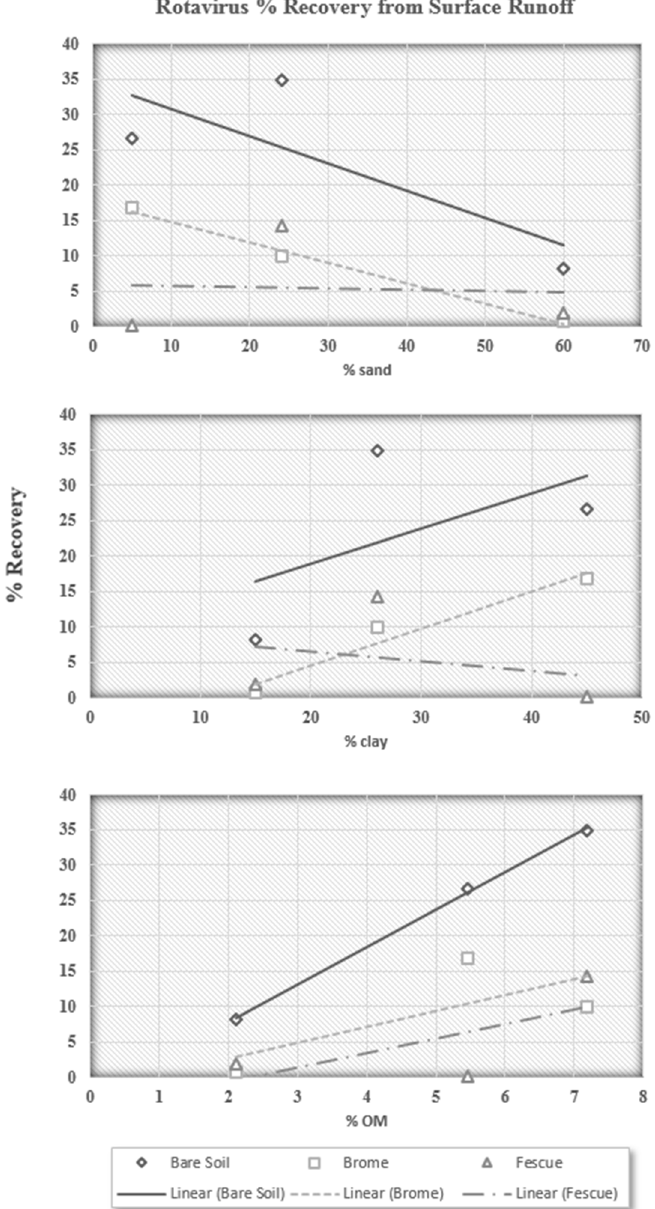
Figure 3. The recovery of infective rotavirus particles in surface runoff is plotted versus % sand, % clay, and % organic matter.